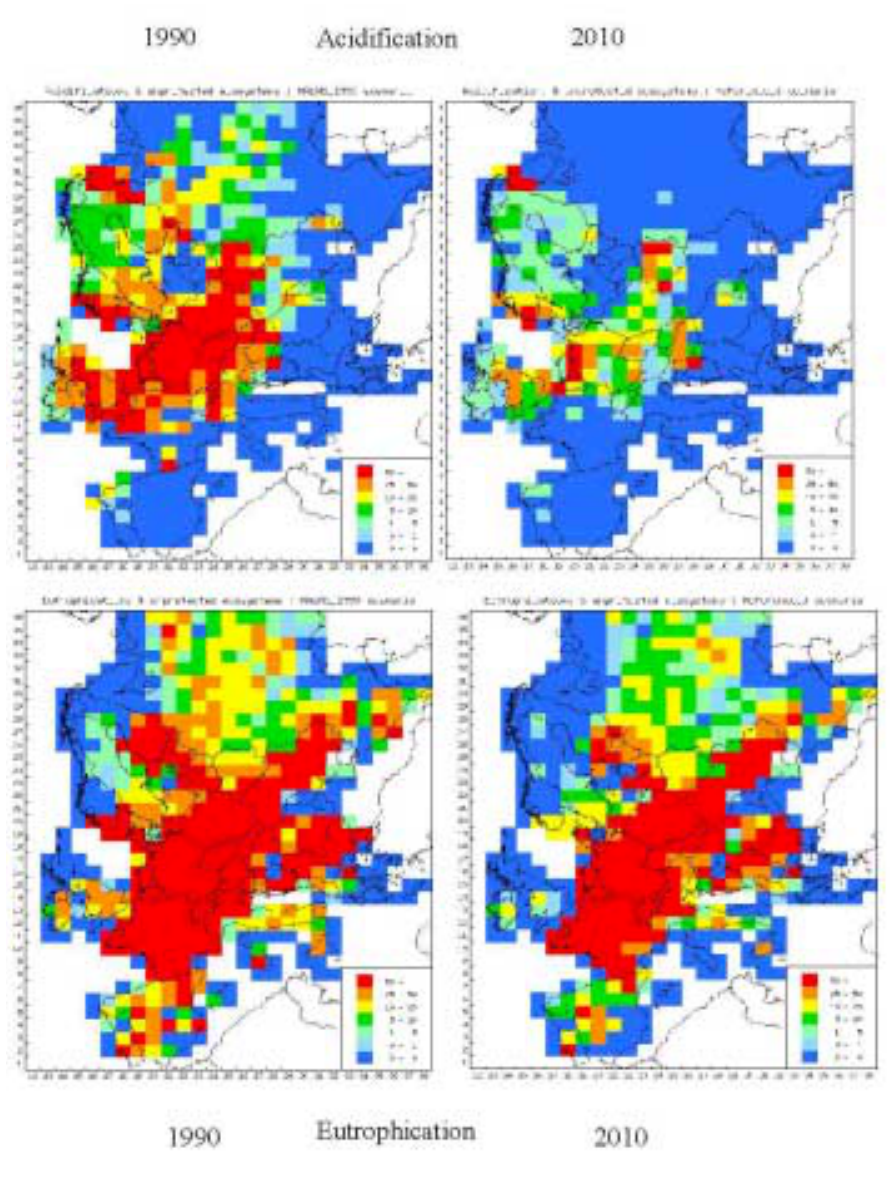
FIGURE 6. Exceedances of critical loads for acidity and nitrogen in 1990 and for the Ref-scenario developed to underpin the Gothenburg protocol. (data from IIASA,